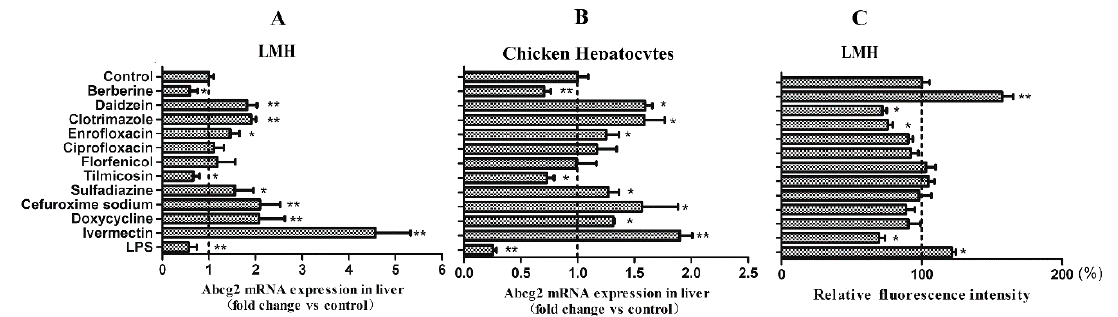
Figure 5. Effects of xenobiotics on the Abcg2 mRNA levels and breast cancer resistance protein (BCRP) efflux function. ( A ) Abcg2 mRNA expression in LMH cells; ( B ) Abcg2 mRNA expression in chicken hepatocytes; ( C ) relative fluorescence intensity of mitoxantrone under 488 nm excitation (xenobiotic treatment/control). * represents p < 0.05 and ** represents p < 0.01.